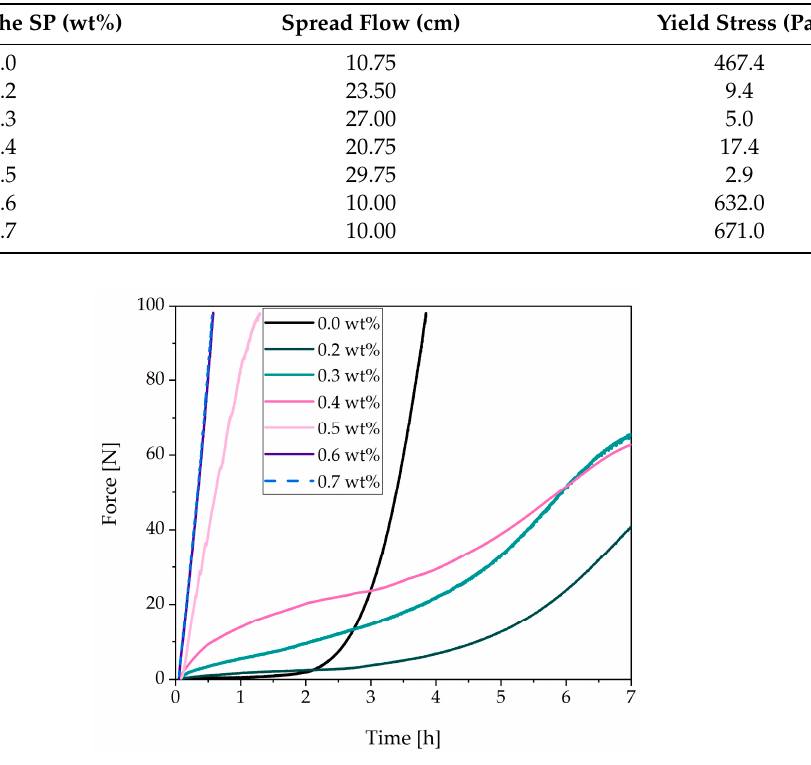
Figure 4. Results of a penetration test (MILD—multipurpose incremental loading device) of CEM I with different dosages of superplasticizer (w/c = 0.36) .